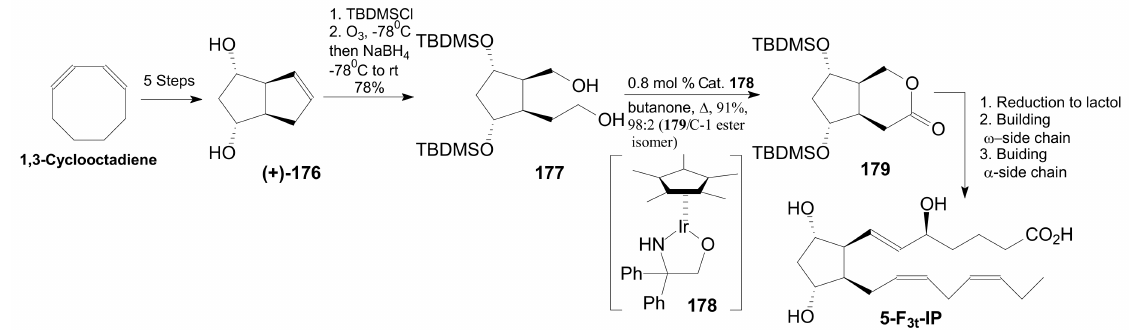
Scheme 36. Synthesis of the cis - trans -lactone 179 from